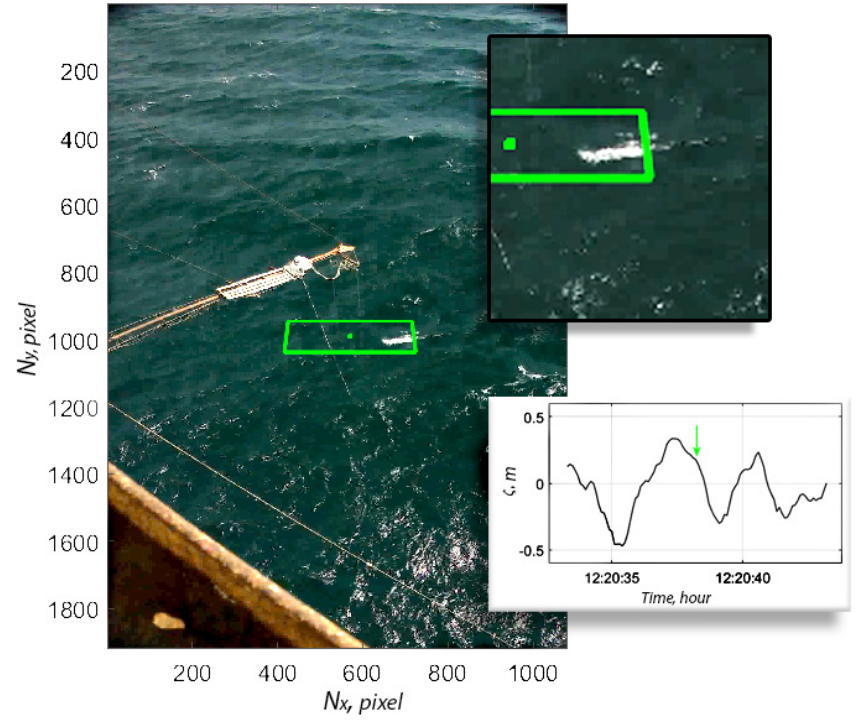
Figure 1. Video frame with wave gauge boom and rectangle (in green) of the sea surface for studying the wave breaking modulations. A green point in the rectangle shows the interception of the wave gauge wire with the sea surface. The insets show ( top ) an enlarged fragment of the frame and ( bottom ) a period of the sea surface elevation recording, where an arrow marks the instant of time corresponding to this frame.